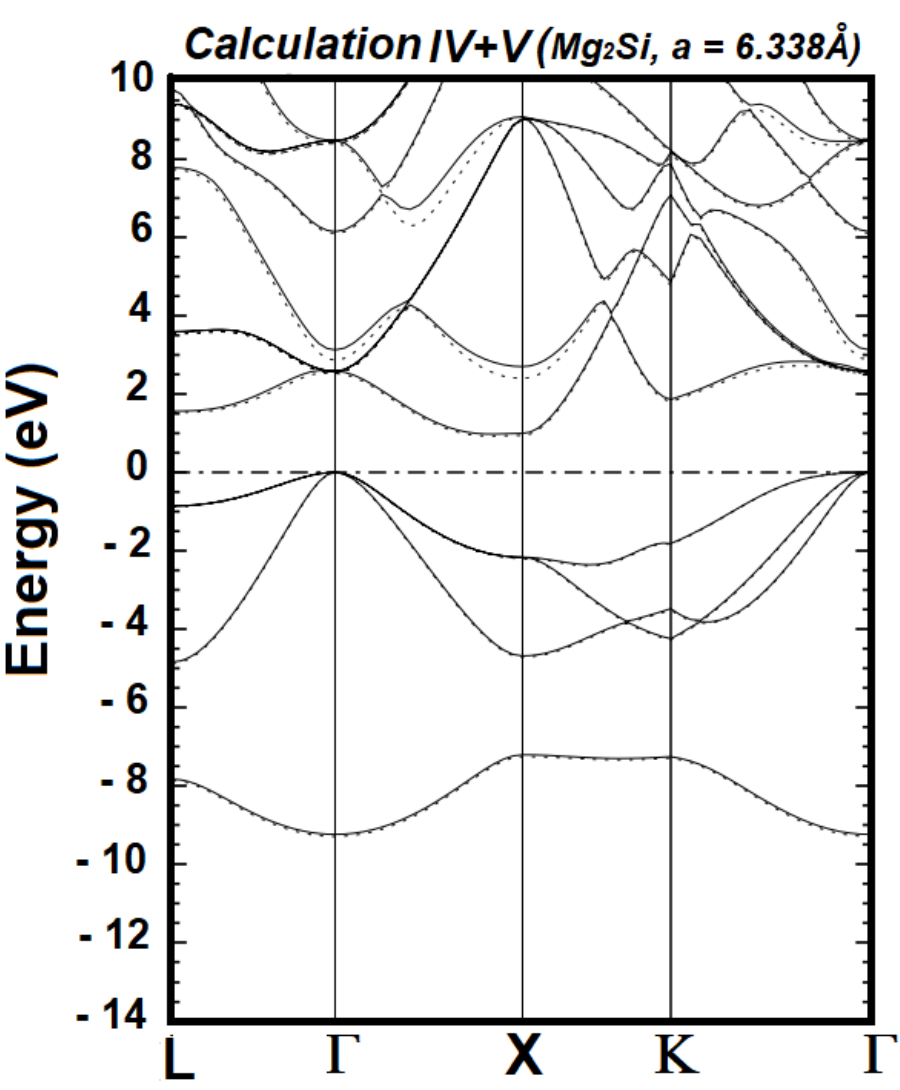
Figure 2. Electronic energy bands of cubic Mg 2 Si from Calculation IV (solid lines) and Calculation V (dotted lines), upon setting the Fermi level to zero; this level is indicated by the horizontal dashed- dotted line.